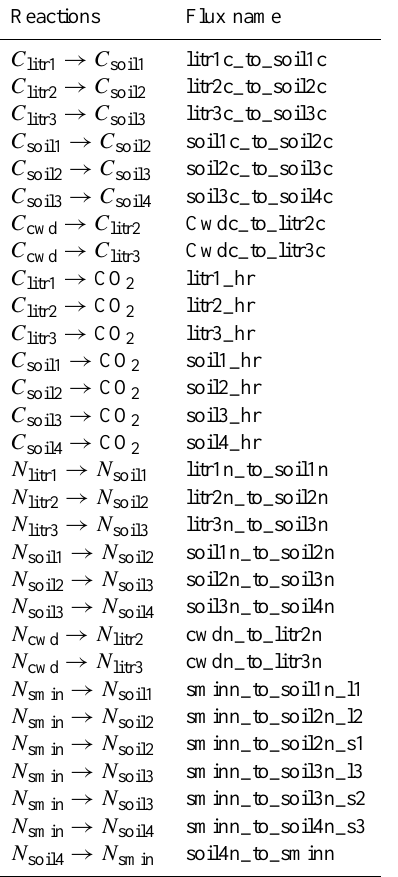
Table 1. Decomposition processes created from the ODEs in CLM-